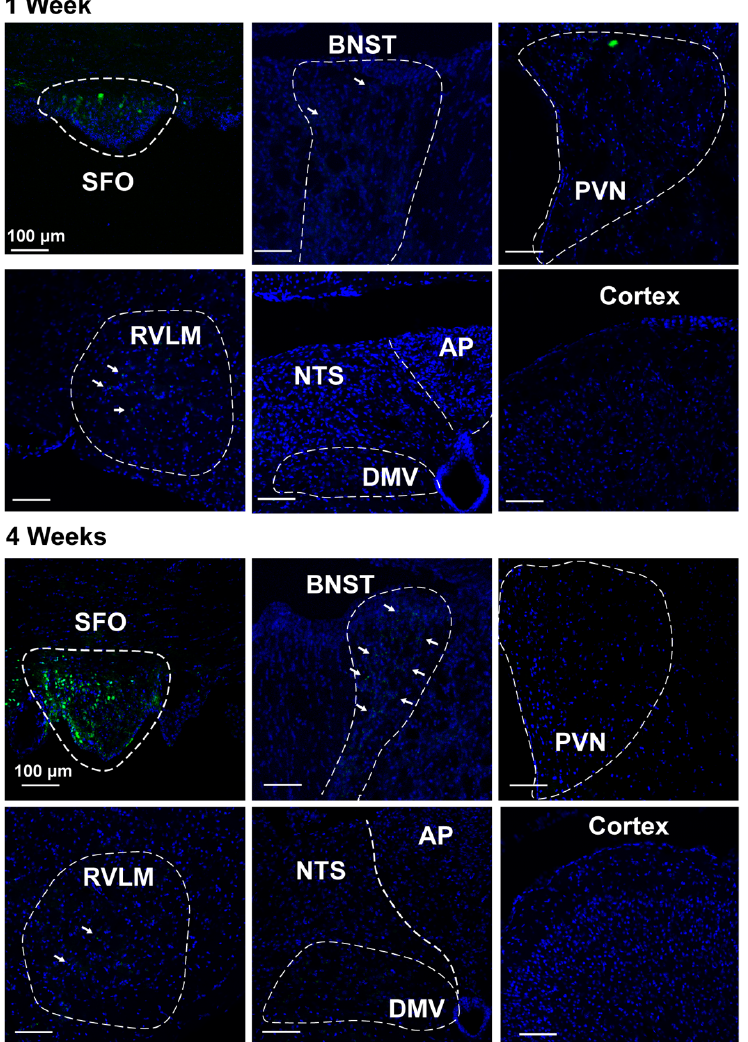
Figure 4. SFO-targeted AAV2-eGFP expression. Images of the SFO, cortex, BNST, PVN, RVLM, DMV, and NTS from mice that received an SFO injection of AAV2-eGFP 1 and 4 weeks after injections. eGFP expression (green) was detected in the cell bodies of SFO, but not in the bed of nucleus stria terminalis (BNST), paraventricular nucleus of the hypothalamus (PVN), rostral ventrolateral medulla (RVLM), nucleus tractus solitarius (NTS), dorsal motor nucleus of the vagus (DMV), area postrema (AP), or cortex. White arrows indicate visible projections (green dots, eGFP) to the BNST and RVLM. No obvious eGFP was observed in other brain regions examined.